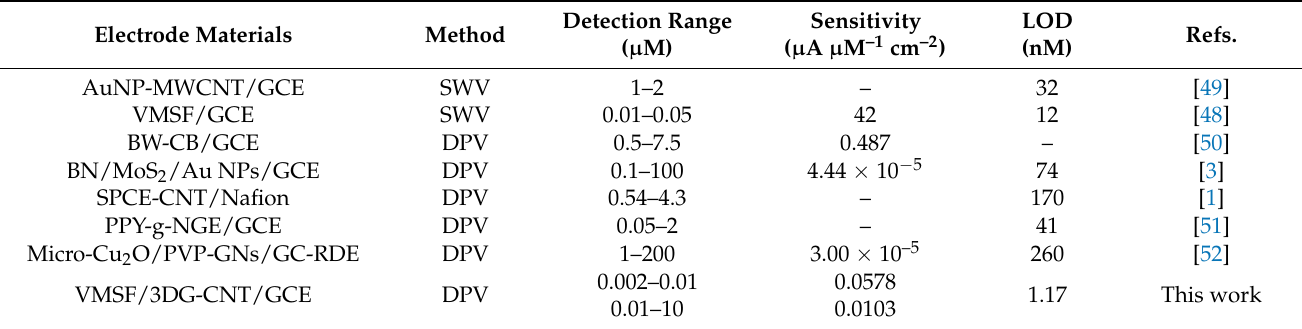
Figure 5. ( a ) DPV curves of the VMSF/3DG-CNT/GCE obtained in PBS (0.1 M, pH = 6) containing different concentrations of PQ. The inset is the magnified view of the DPV curves in the low concen- tration region. ( b ) The calibration curve for PQ. The inset in ( b ) shows the calibration lines in the low concentration range. The error bars represent the standard deviation (SD) of three measurements. Table 1. Comparison of the determination of PQ among different